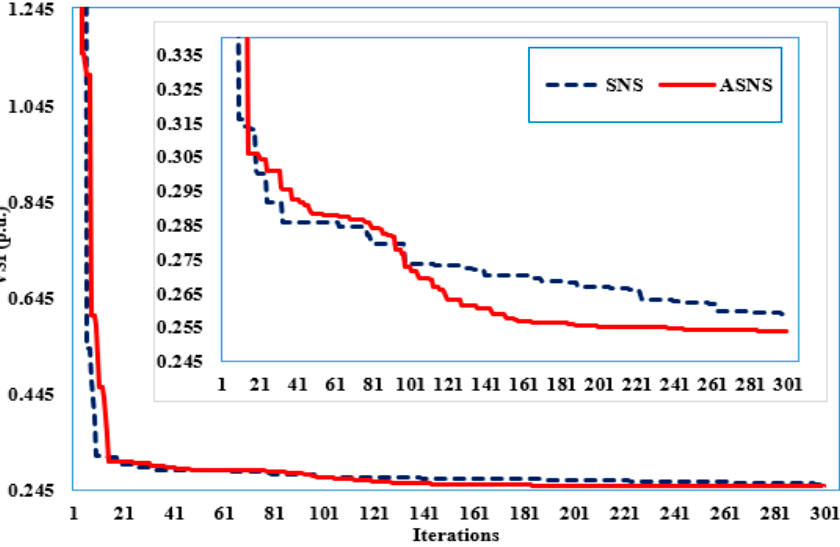
Figure 11. Convergence features of the proposed ASNS and SNS for Case 3 of the IEEE 57-bus grid.